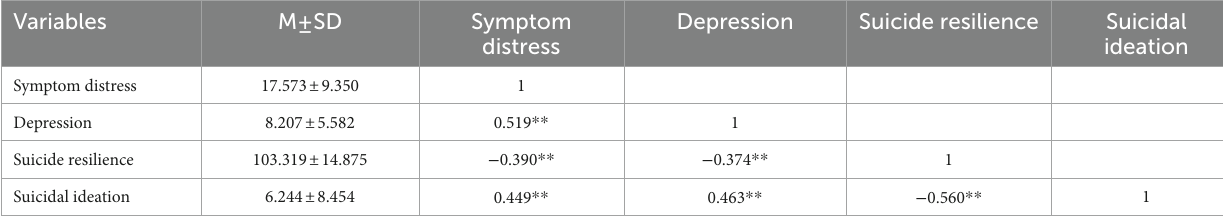
TABLE 3 Mediating effect of depression on the relationship between symptom distress and suicidal ideation.